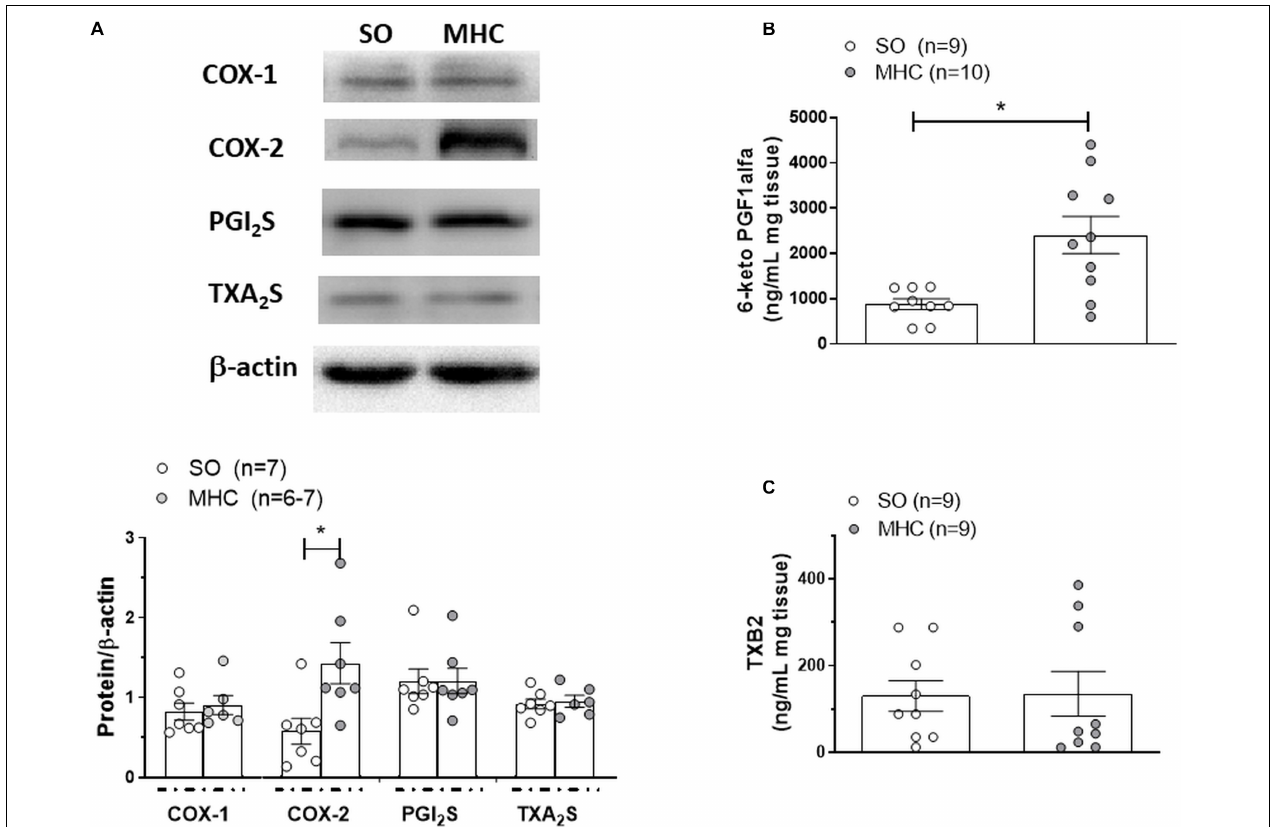
FIGURE 6 | (A) Western blot analysis for cyclooxygenase (COX) 1 and 2, PGI 2 synthase (PGI 2 S) and TXA 2 synthase (TXA 2 S) in cerebral arteries from Sham-Operated (SO) and microsurgical liver cholestasis (MHC) rats. The blots are representative of 6–7 segments from each group. Lower panels show densitometry analysis for the expression of each protein. Results (mean + SEM) were expressed as the relation between the signal obtained for the protein analyzed and the signal obtained for β -actin. * P < 0.05 SO vs MHC (Student t -test). Effect of microsurgical liver cholestasis (MHC) on cerebral artery 6-Keto PGF 1 α release (B) ; (SO: n = 9 animals; MHC: n = 10 animals) and TXB 2 release (C) ; (n = 10 animals from each experimental group) Results (mean ± SEM) were expressed as pg prostanoid/mL mg tissue. *P < 0.05 SO vs MHC (Student t